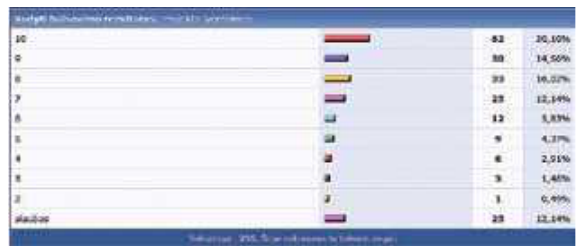
Table 2. Prosecutor's Office building